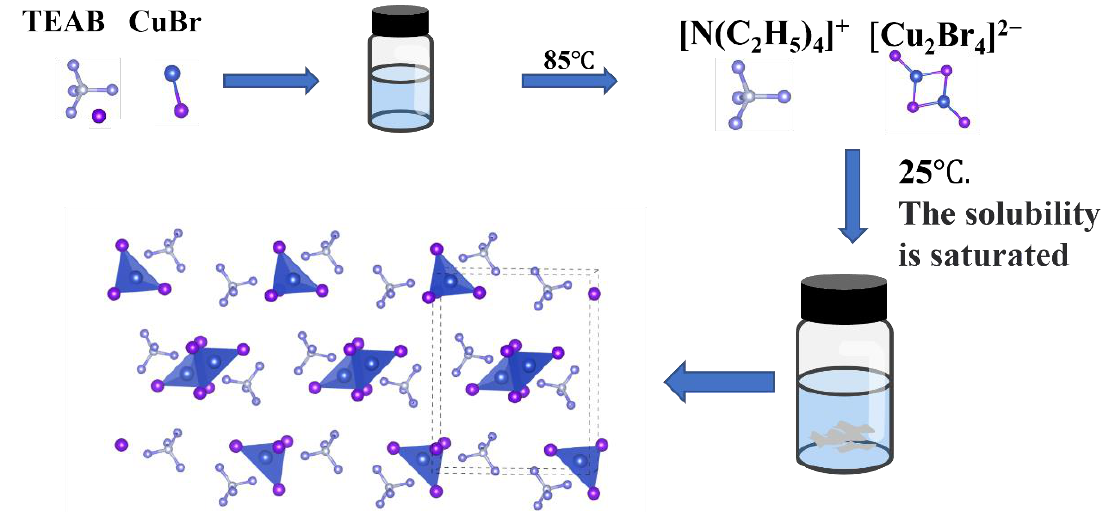
Figure 1. Schematics of the preparation of the TEA 2 Cu 2 Br 4 crystals with liquid-phase cooling pre- cipitation.